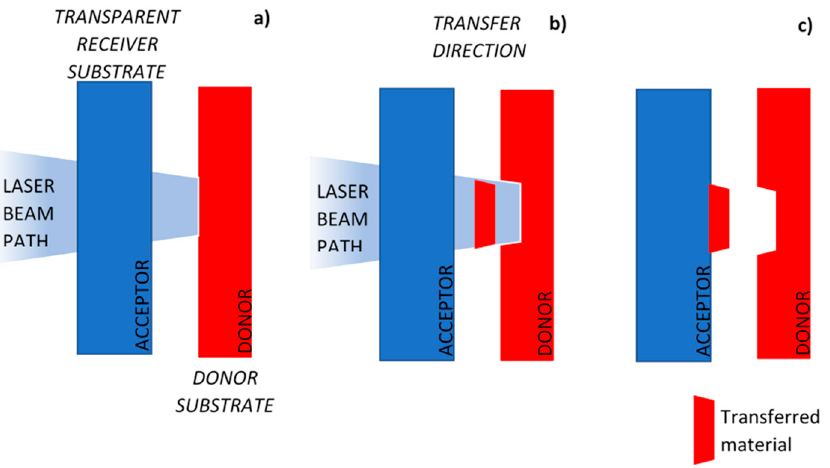
Figure 2. Illustration of the LIBT process: ( a ) the laser beam crosses the acceptor and irradiates the donor; ( b ) the material flies from the donor to the acceptor; ( c ) the material is deposited on the acceptor surface.